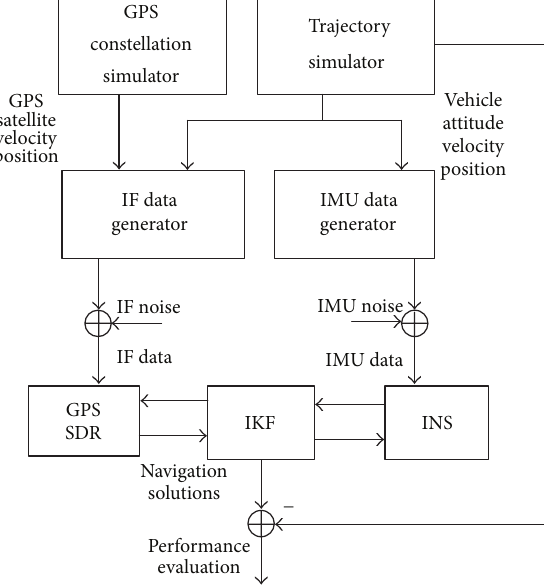
Figure 6: Simulation platform